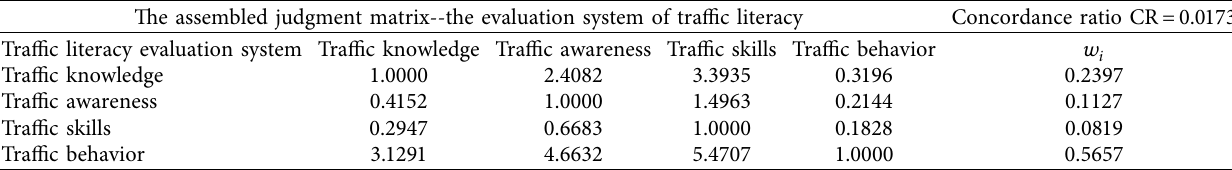
Table 2: Judgment matrix of traffic literacy evaluation system and weight.